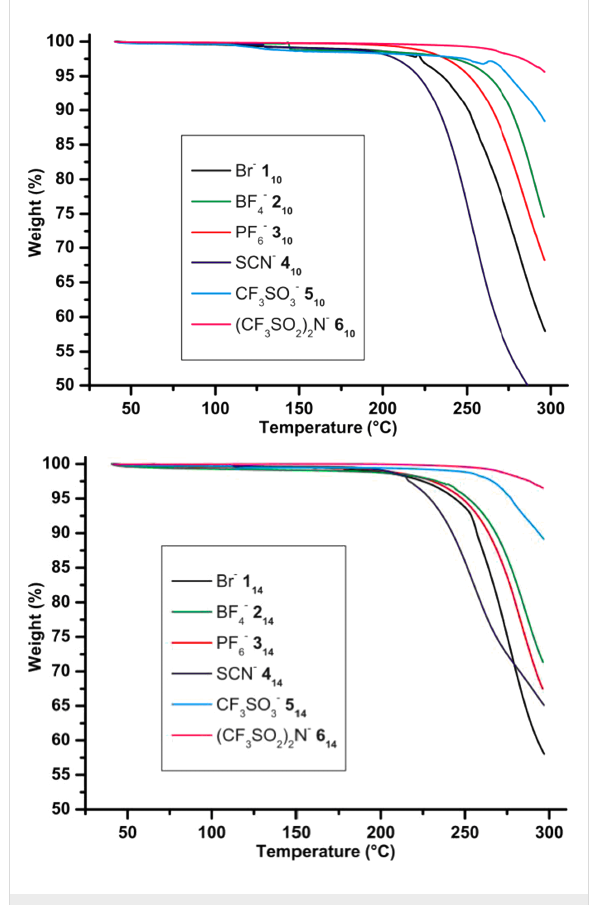
Figure 3: TGA measurements of the two entire series 1 10 – 6 10 and 1 14 – 6 14 (rate 10° C·min −1 , in